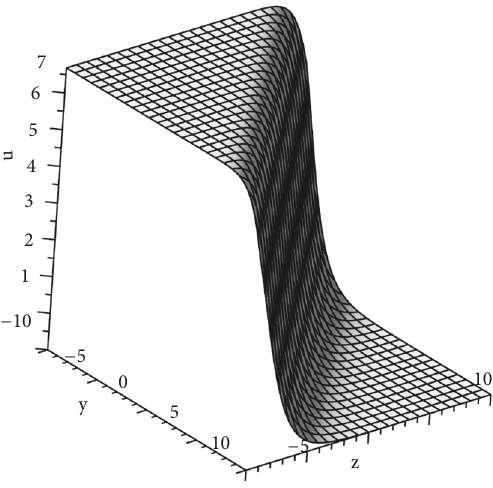
Figure 3: Kink wave profile of 𝑢 5,6 , 𝛼 = 1 , 𝛾 = 1 , 𝑑 = 0.5 , 𝑒 = 0.5 , 𝛽 = 4 , 𝑥 = 0 , and 𝑡 = 0 .